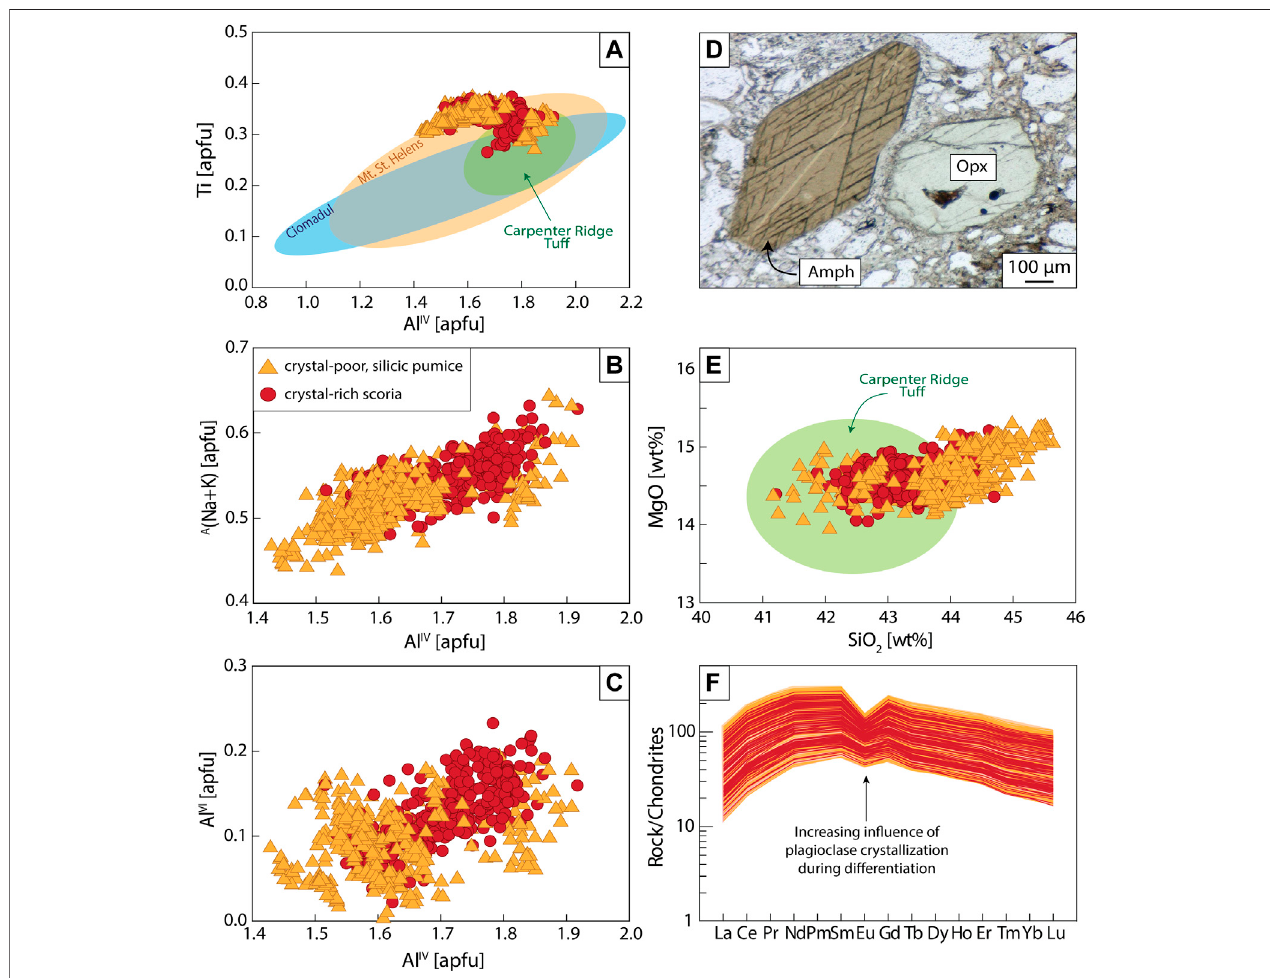
FIGURE6| Amphibolecompositioninsilicic,crystal-poorpumiceandcrystal-richscoria.Binaryplotsof (A) Ti, (B) A (Na+K)and (C) Al VI vs.Al IV illustratesubstitution conditions in Aso-4 amphibole. Comparisons to amphiboles from Mount St. Helens (orange fi elds, Humphreys et al., 2019), Ciomadul (blue fi elds, Kiss et al., 2014) and CarpenterRidgeTuff(green fi elds,Bachmann etal.,2014;Lipman,2006)indicatehighhomogeneityinAso-4amphibolessimilar toCRTsamples. (D) Photomicrograph of a late-erupted, euhedral amphibole from crystal-rich scoria together with orthopyroxene. (E) Plot of MgO vs. SiO 2 comparing Aso-4 amphibole to CRT amphiboles. (F) Chondrite-normalized(SunandMcDonough,1989)REEpatternsofAso-4 amphibolesshowarangeofREE compositions.Euanomalyisprogressively increasing with ongoing melt differentiation due to increasing in fl uence of plagioclase crystallization. Measurement errors are smaller than the symbol.